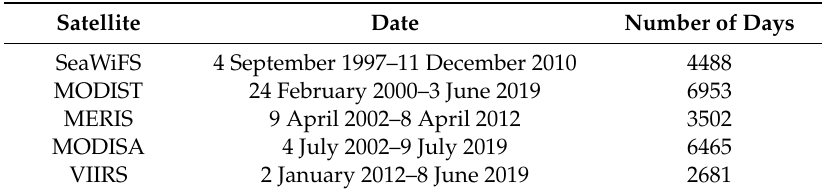
Table 1. Overall information of Chlorophyll-a concentration (Chl-a) dataset from five satellites.